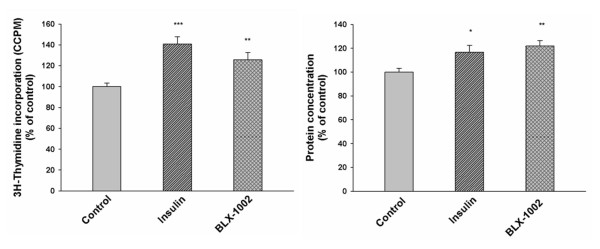
Insulin and BLX-1002 stimulate HCAEC proliferation in high glucose. HCAECs were incubated at 11 mM of glucose in medium supplemented with 0.5% FBS for 24 h in the presence or absence of insulin lispro (100 pM) or BLX-1002 (1 μM). Eight hours prior to the end of the incubation, cells were pulsed with [3H]thymidine. Cells were then harvested and [3H]thymidine incorporation into DNA was measured using a microplate scintillation & luminescence counter and the protein concentration of the samples was measured using DC™ Protein Assay. * denotes P < 0.05, ** denotes P < 0.01, *** denotes P < 0.001 for a chance difference vs. control by Student's t-test.